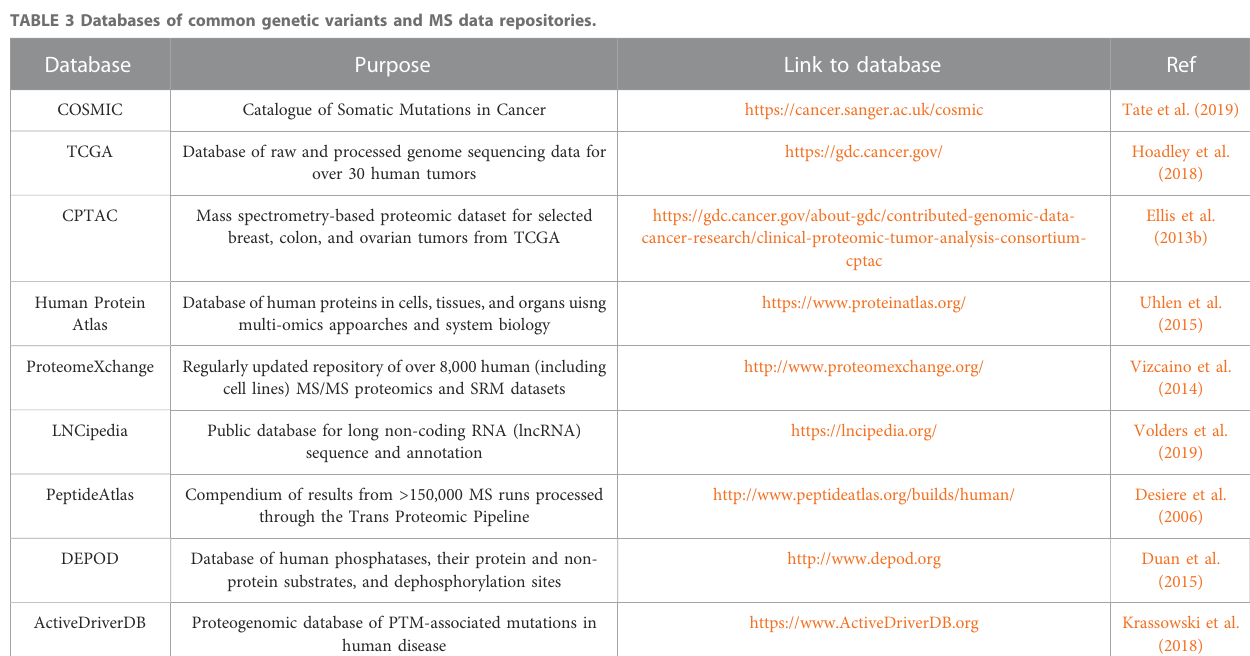
proteomics and to generate high-throughput MS-based assays for clinical use. Targeted approaches, including multiple reaction monitoring (MRM) and parallel reaction monitoring (PRM),